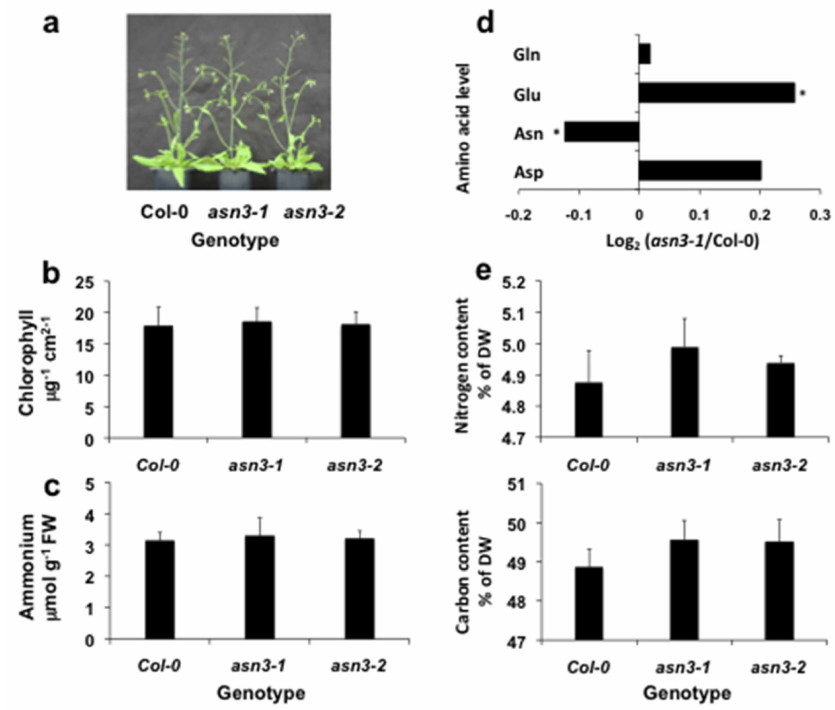
Figure 3. Phenotypic analysis of Arabidopsis asn3-1 and asn3-2 lines. ( a ) Representative visual growth phenotype; ( b ) chlorophyll content; and ( c ) ammonium content in rosette leaves of 35-day-old wild-type (Col-0), asn3-1 and asn3-2 rosettes; ( d ) ratios of selected amino acid contents in young siliques of Col-0 and asn3-1 expressed as Log 2 [amino acid] asn 3 ´ 1 /[amino acid] Col-0 . A positive value represents a higher metabolite content in the asn3-1 line, and a negative value corresponds to a lower metabolite content in the asn3-1 line; ( e ) total nitrogen and carbon contents in dry seeds of Col-0, asn3-1 and asn3-2 lines. The values represent the mean ˘ SE of three biological replicates. Asterisks indicate significant differences between the wild-type and transgenic lines with a Student’s t -test p values * p <